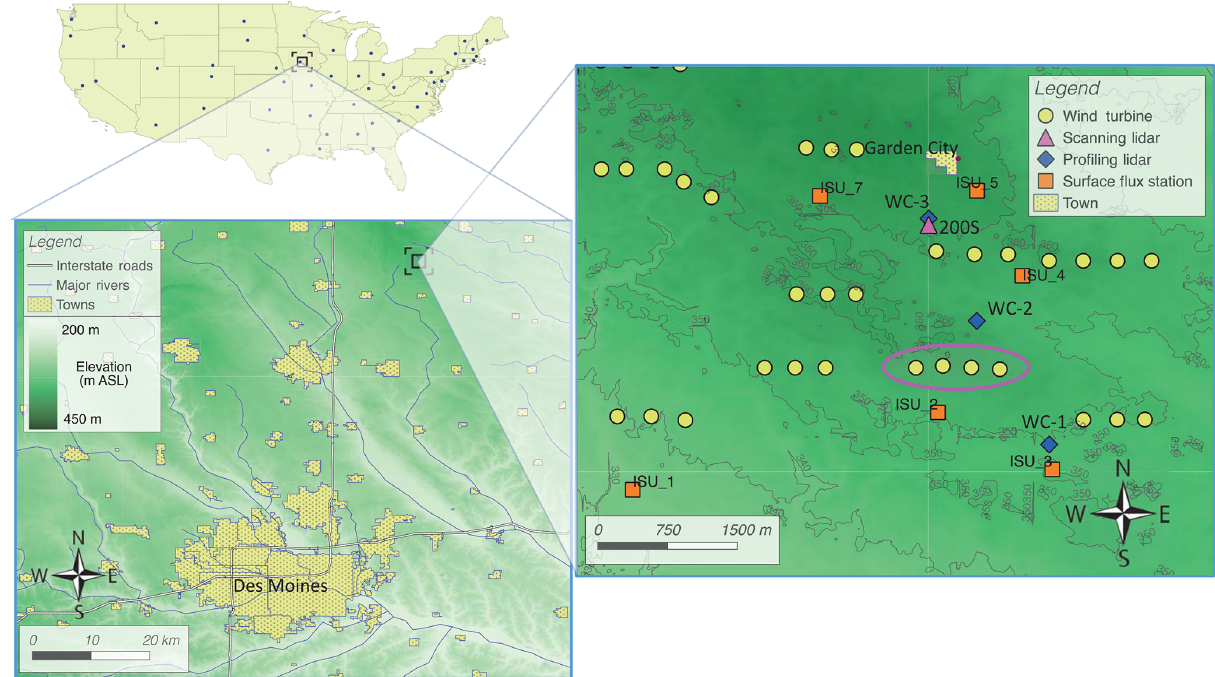
Figure 1. Schematic view of the part of the wind farm in central Iowa where the CWEX-13 field campaign took place. The row of four turbines whose wakes are detected by the scanning lidar is highlighted in a purple ellipse.